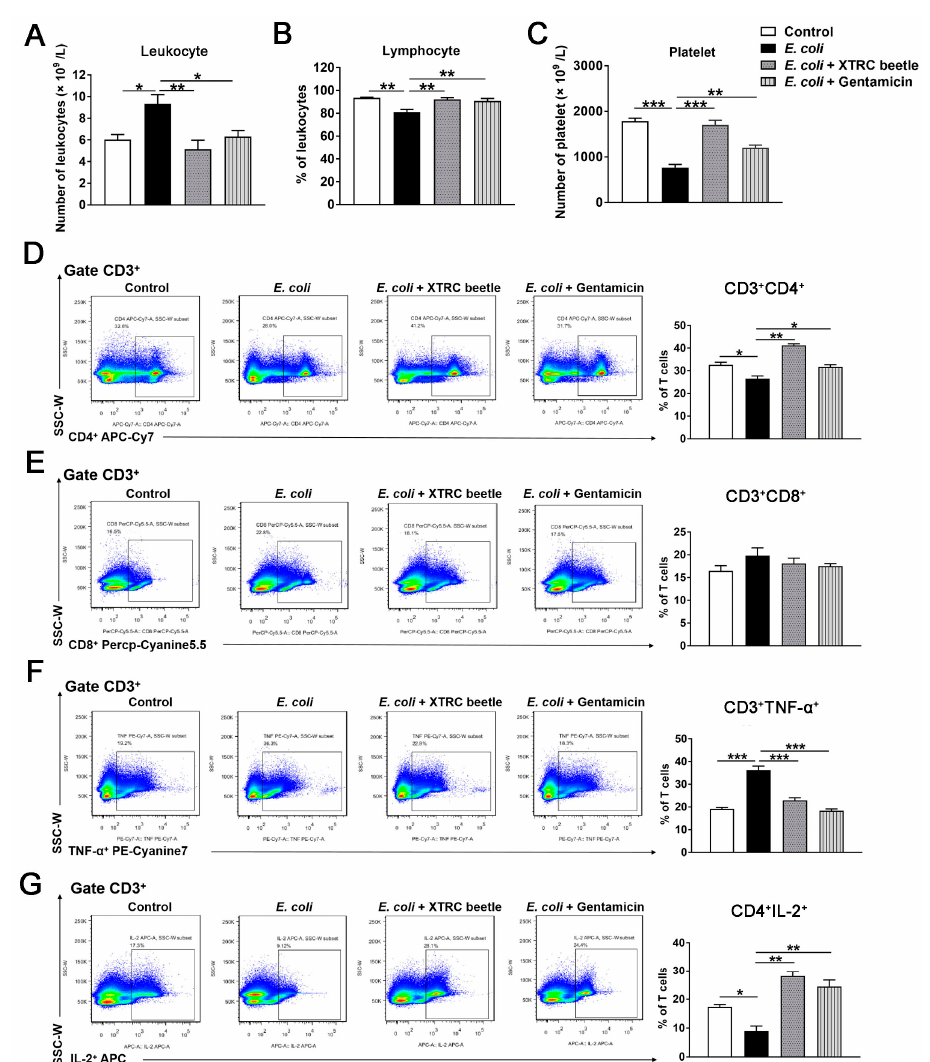
Figure 2. Effects of Z. morio hemolymph on peripheral blood parameters in E. coli -induced mastitis. ( A ) The total number of peripheral blood leukocytes. ( B ) The percentage of lymphocytes on blood leukocytes. ( C ) The total number of peripheral blood platelet. ( D – F ) The percentage of CD4 + , CD8 + and TNF-a + T cells among CD3 + T cells determined in peripheral blood lymphocytes of mice in different groups by flow cytometric analysis. The representative flow cytometry dot plot shows the gating strategy for CD4, CD8 and TNF-a expression in peripheral CD3 + T cells. ( G ) The percentage of IL-2+ T cells among CD3 + CD4 + T cells determined in peripheral blood lymphocytes of mice in different groups by flow cytometric analysis. The representative flow cytometry dot plot shows the gating strategy for IL-2 expression in peripheral CD3 + T cells. XTRC beetle stands for Z. morio hemolymph-treatment. The data from each group are presented as the mean ± SEM ( n = 8 per group). * p < 0.05, ** p < 0.01, *** p < 0.001.